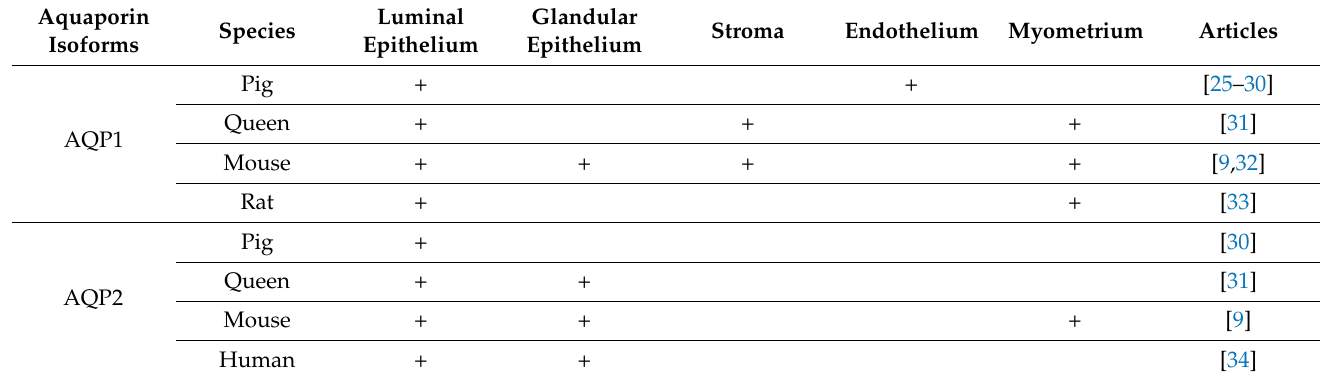
Table 1. Expression of aquaporin isoforms in uterus